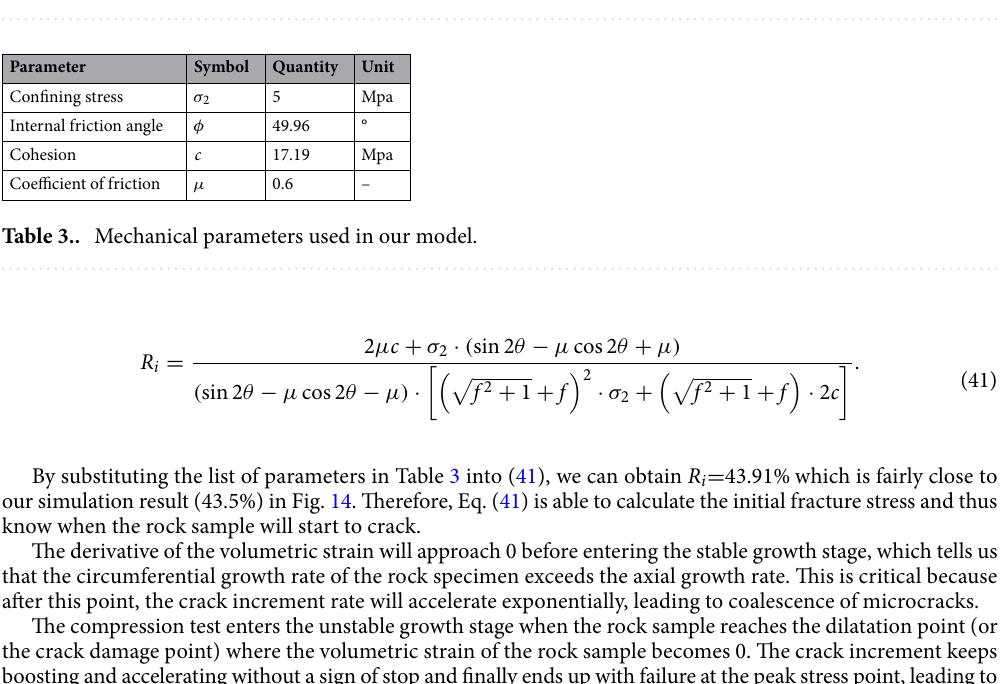
Figure 14. Stress–strain curves under 5 Mpa confining stress showing the stages of crack growth.